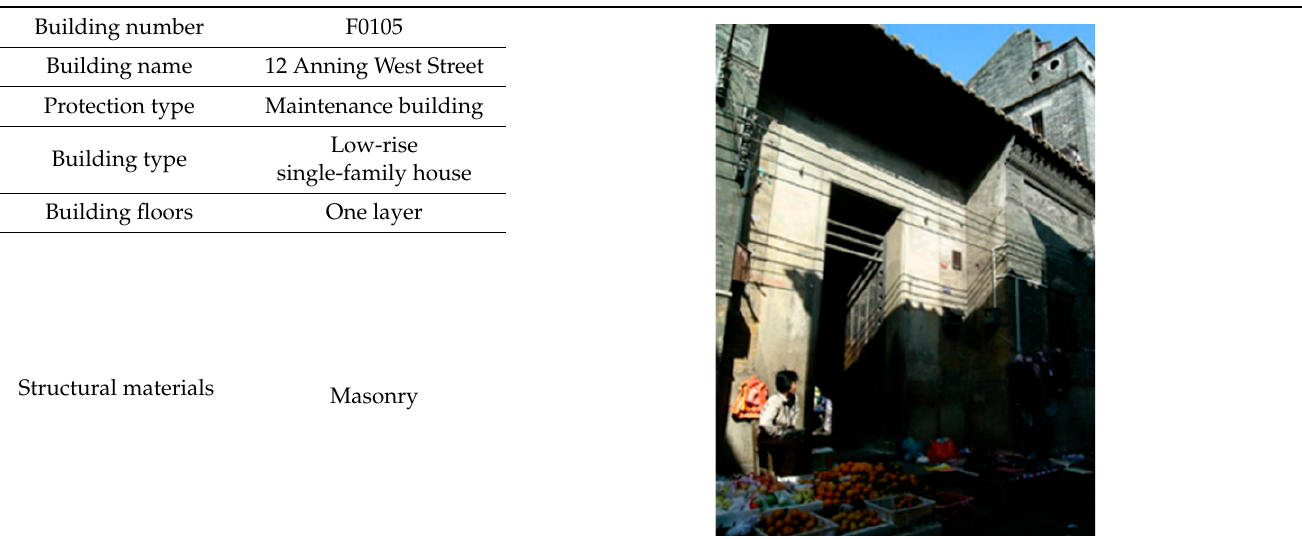
Table 3. Housing repair archives.